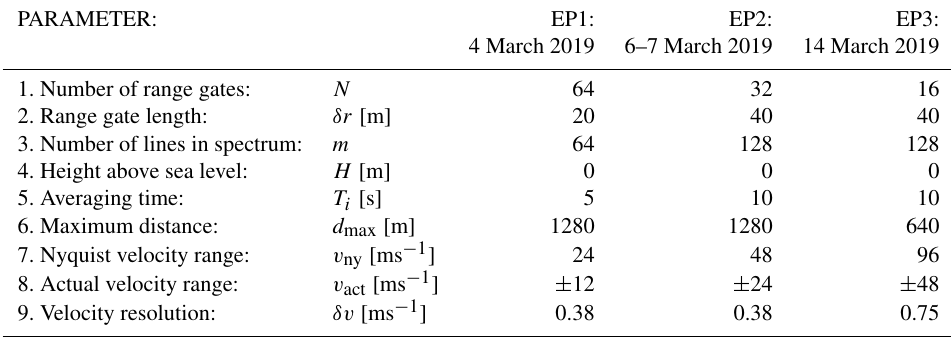
Table 1. MRR parameter settings (parameters 1–5) for the three different evaluation periods investigated and the resulting MRR limits (parameters